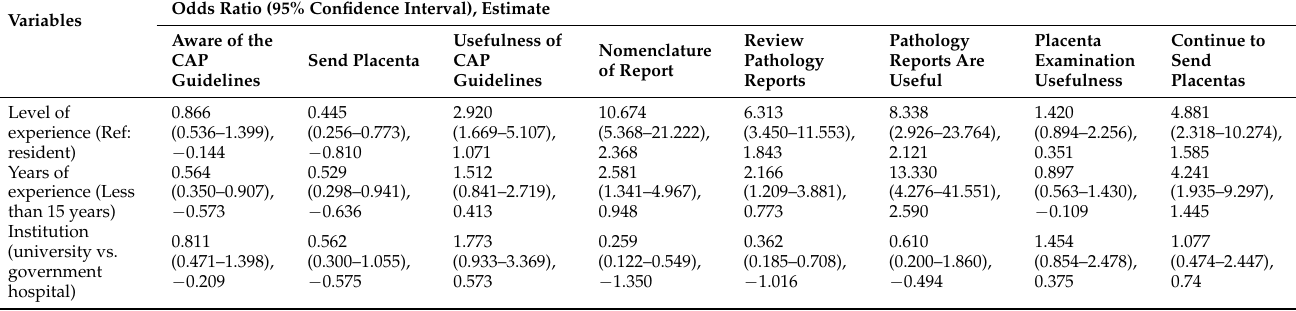
Table 6. Multinomial logistic